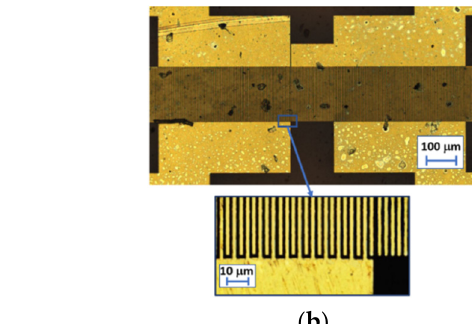
parameter and ( b ) the phase for device #1 with- 12